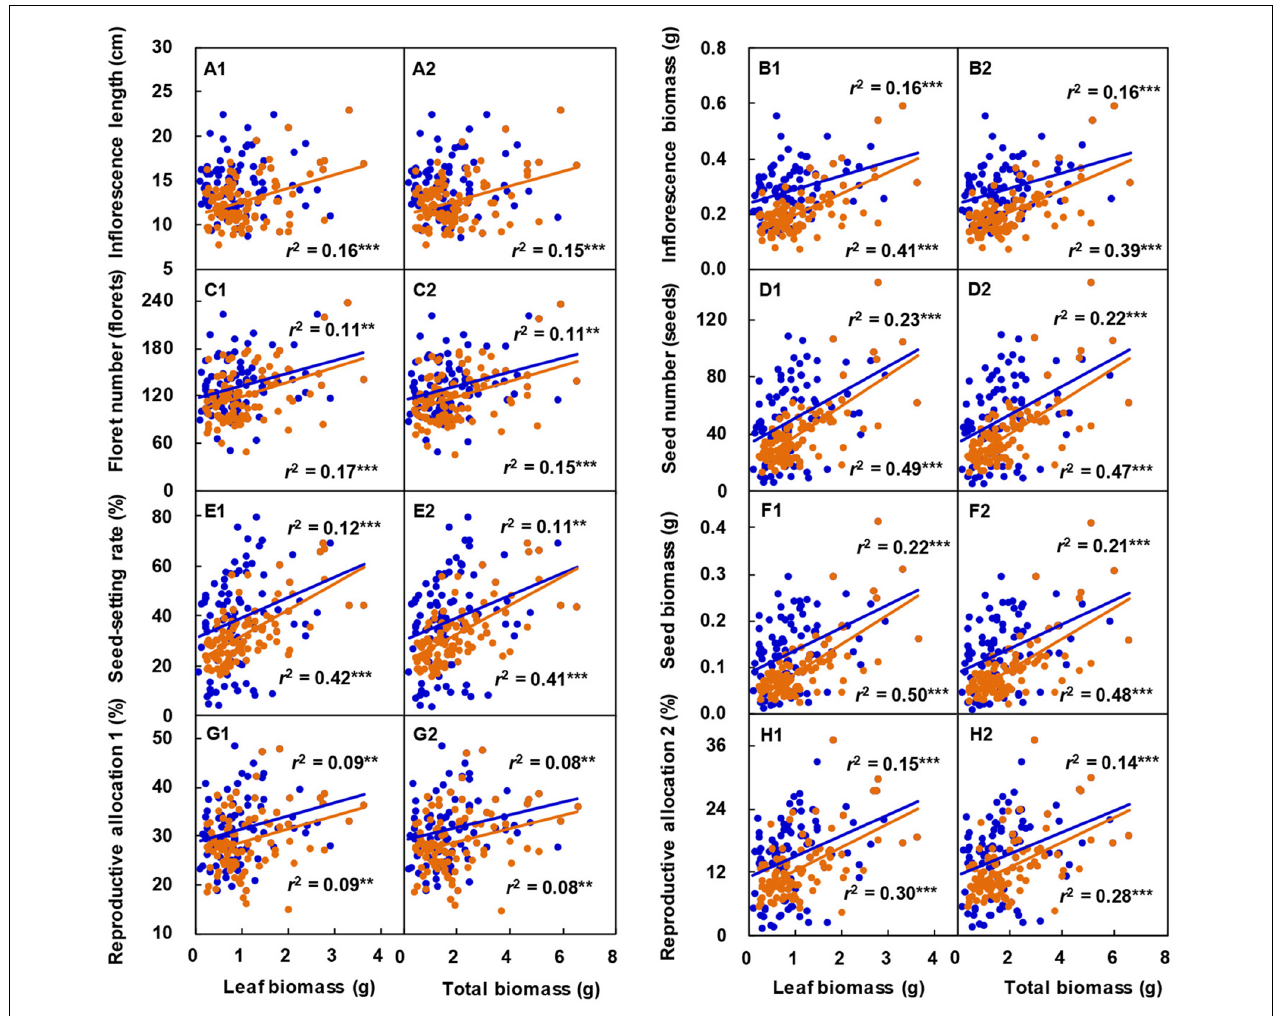
FIGURE 6 | Correlation between the sexual reproductive characteristics and both leaf biomass (A1–H1) and total biomass (A2–H2) of vegetative ramets connected to tillering nodes in Leymus chinensis populations over two consecutive years. The colored circles and lines represent observed data and their fitting lines in 2017 (blue, n = 100) and 2018 (orange, n = 100). ** P < 0.01; *** P < 0.001.